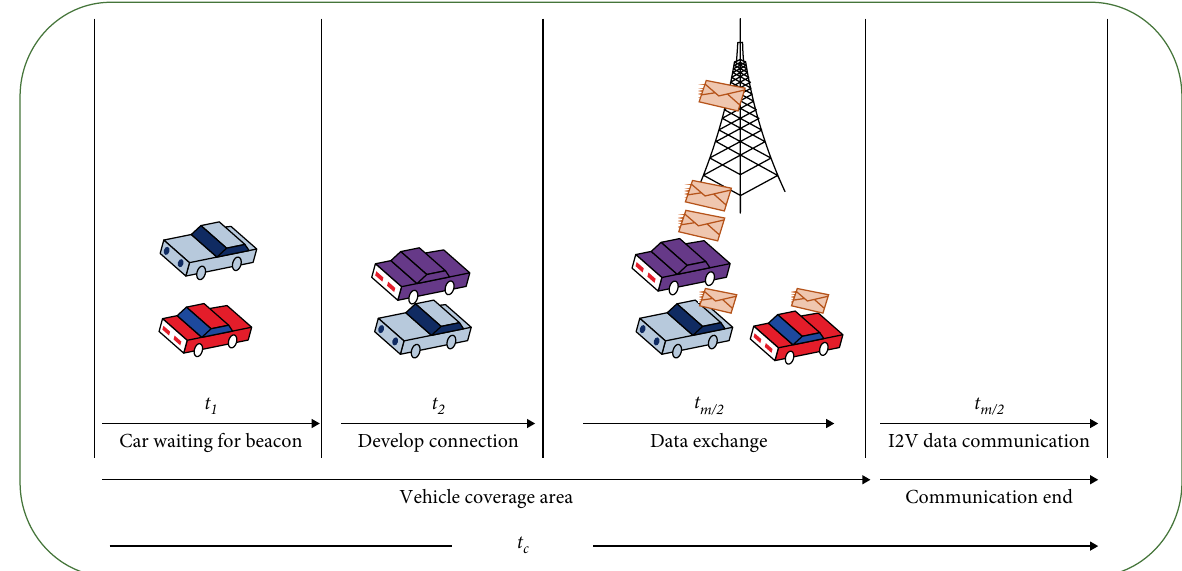
Figure 3: Developing communication between RSU and passing by